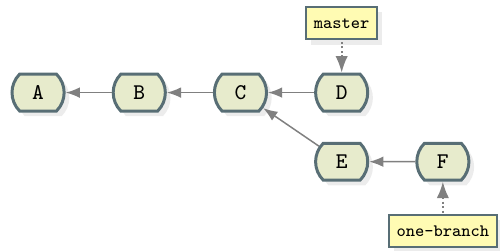
Figure 1. Example of a directed acyclic graph as defined by the versioning mechanism. Every node knows it’s parent, therefore the graph can be traversed from the leafs to the root. Branches, which are only pointers to a version, act as starting points of a traversal, therefore defining the actual line of